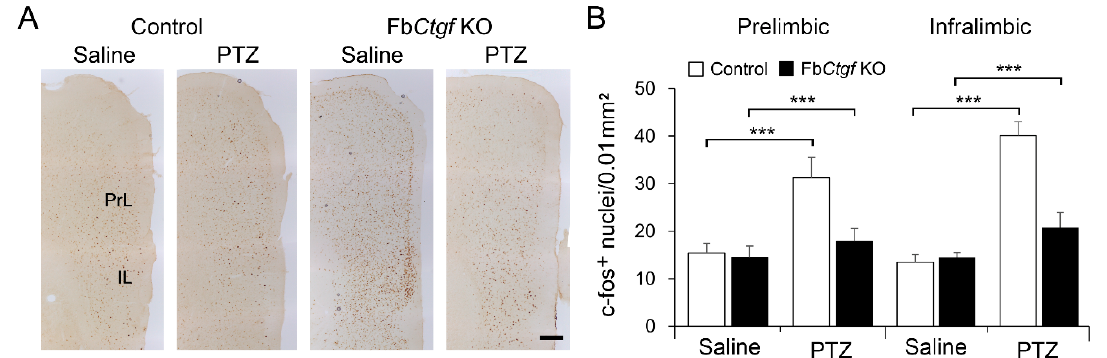
Figure 7. Expression of c-fos in the prelimbic and infralimbic cortices ( A ) and the densities were quantified ( B ). For saline group, n = 3 per genotype; for PTZ group, n = 5 per genotype. Results are mean ± SEM. Asterisks indicate significant differences (*** p < 0.001). Bar = 200 μ m.